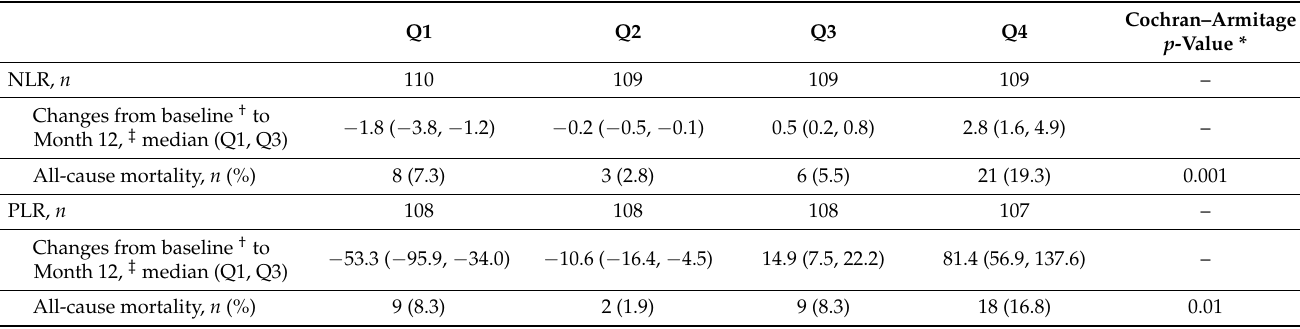
Cochran–Armitage p -Value *